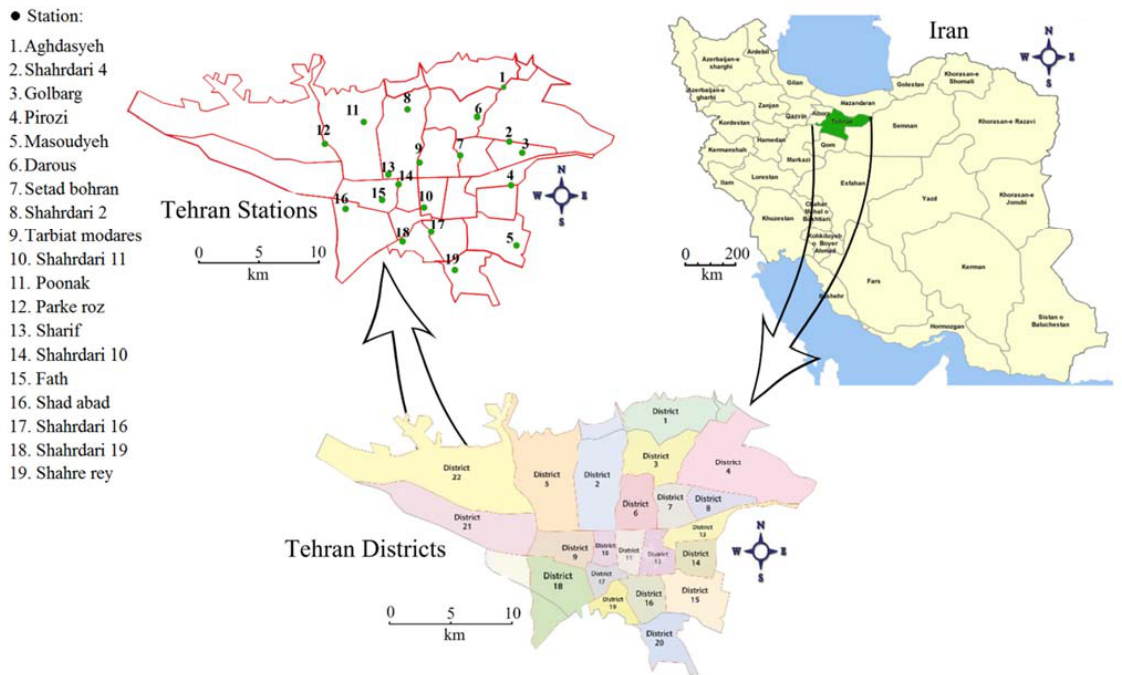
Fig. 1: The study area of research performance and air pollution monitoring stations in Tehran City